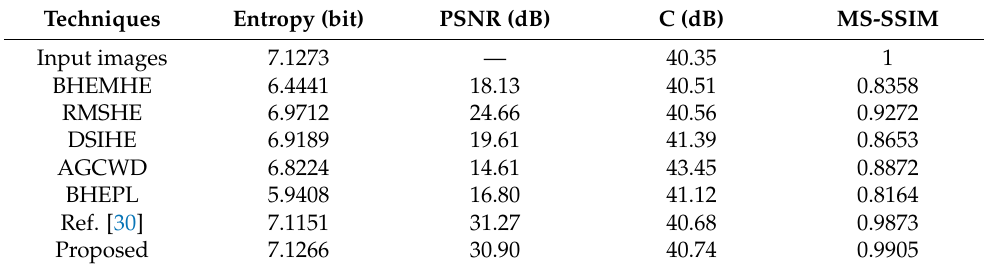
Table 5. Average values of quantitative analyses for 300 test